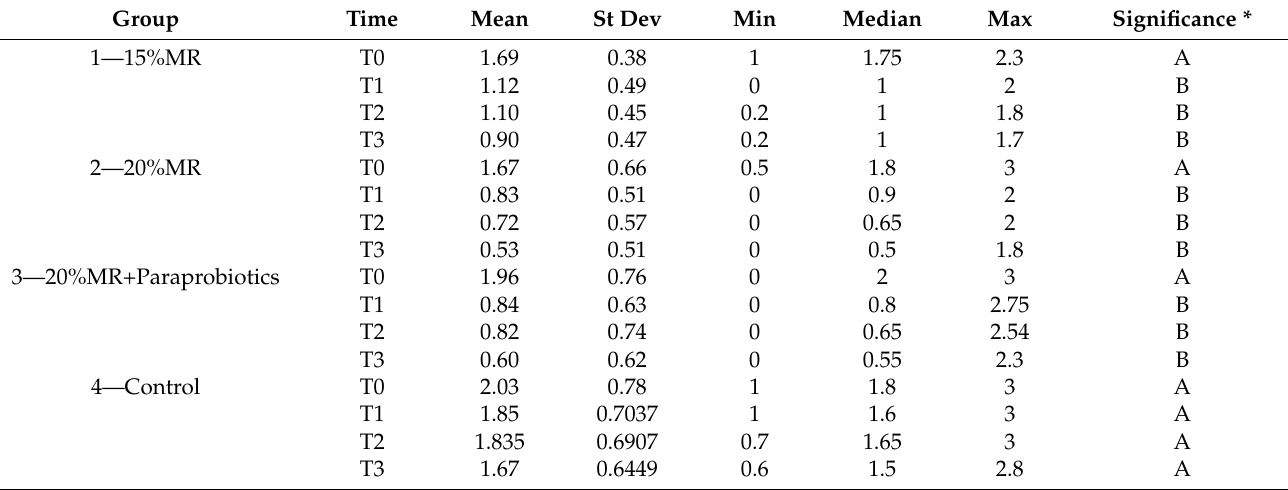
Table 5. Descriptive statistics of modified sulcus bleeding index